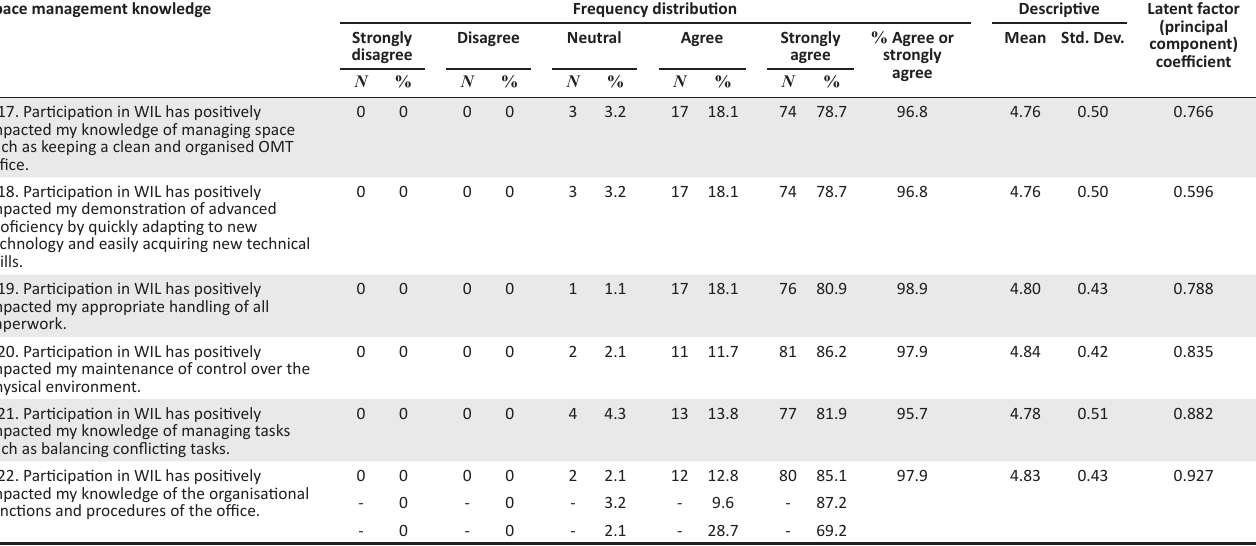
TABLE 4: Space management